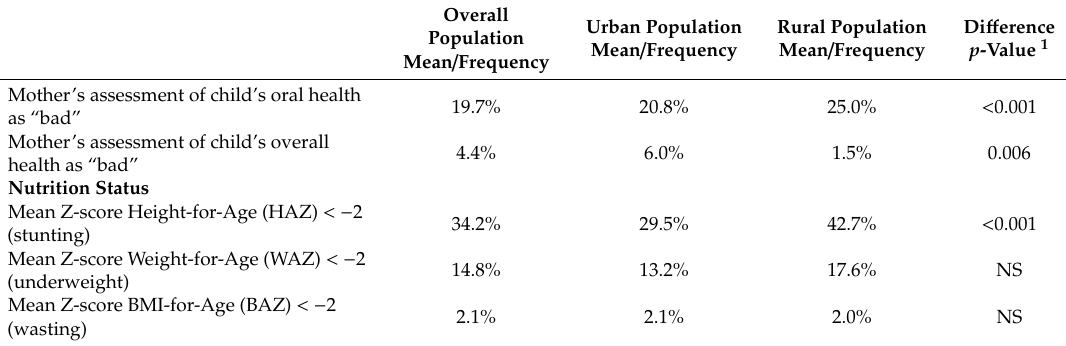
Table 4. Associations between oral health and nutrition. Predictive Variable